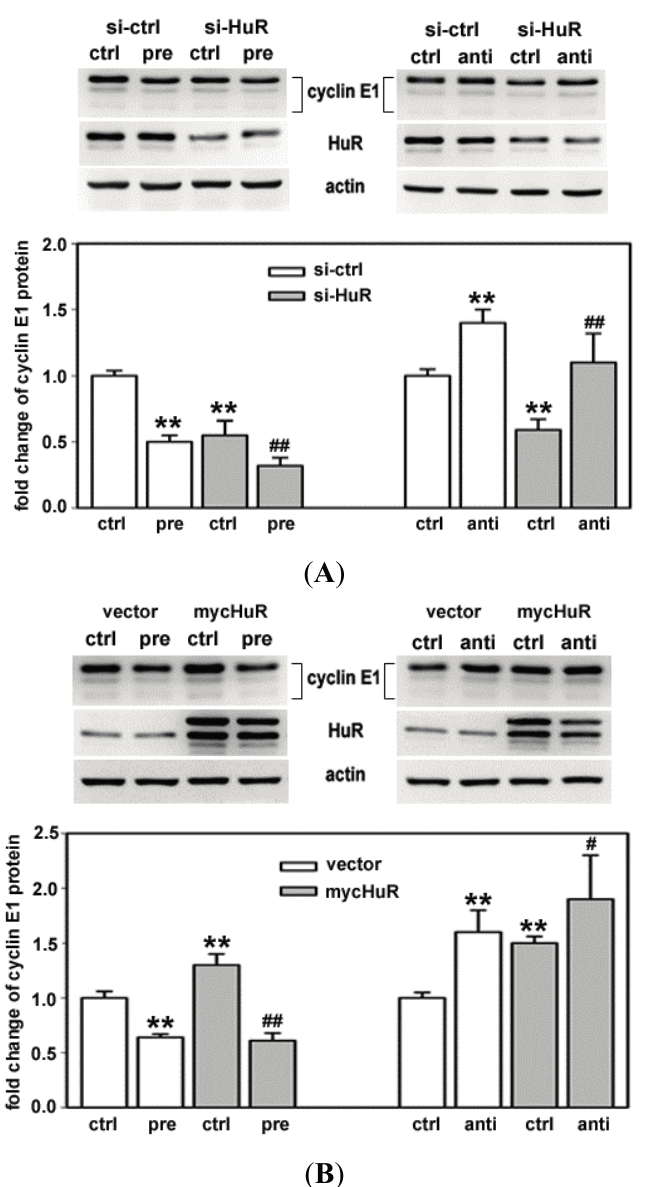
Figure 5. HuR and miR-16 coordinate cyclin E1 expression. MCF-7 cells were transfected with si-ctrl or si-HuR ( A ); pcDNA3.1 vector or pcDNA3.1mycHuR ( B ). 24 h after transfection, the cells were further transfected with control miRNA (ctrl), miR-16 precursor (pre) or antagomir (anti). 48 h after the additional transfection, the levels of cyclin E1 and HuR were detected by western blotting. The blots were reprobed with actin. Representative results are shown from three experiments. The data shown in the graphs are means of three independent experiments with standard deviation ( ** p < 0.01 versus si-ctrl or vec + ctrl miRNA; # p < 0.05 versus mycHuR + ctrl miR-16; ## p < 0.01 versus si-ctrl or vec + ctrl